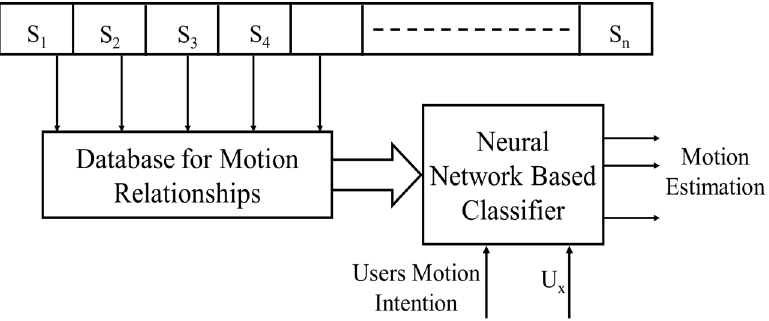
Figure 6. Proposed approach for estimation of identified motion (S n —healthy individuals, n—1, 2, 3, …, U x —residual limb joint angle of the transhumeral amputee).